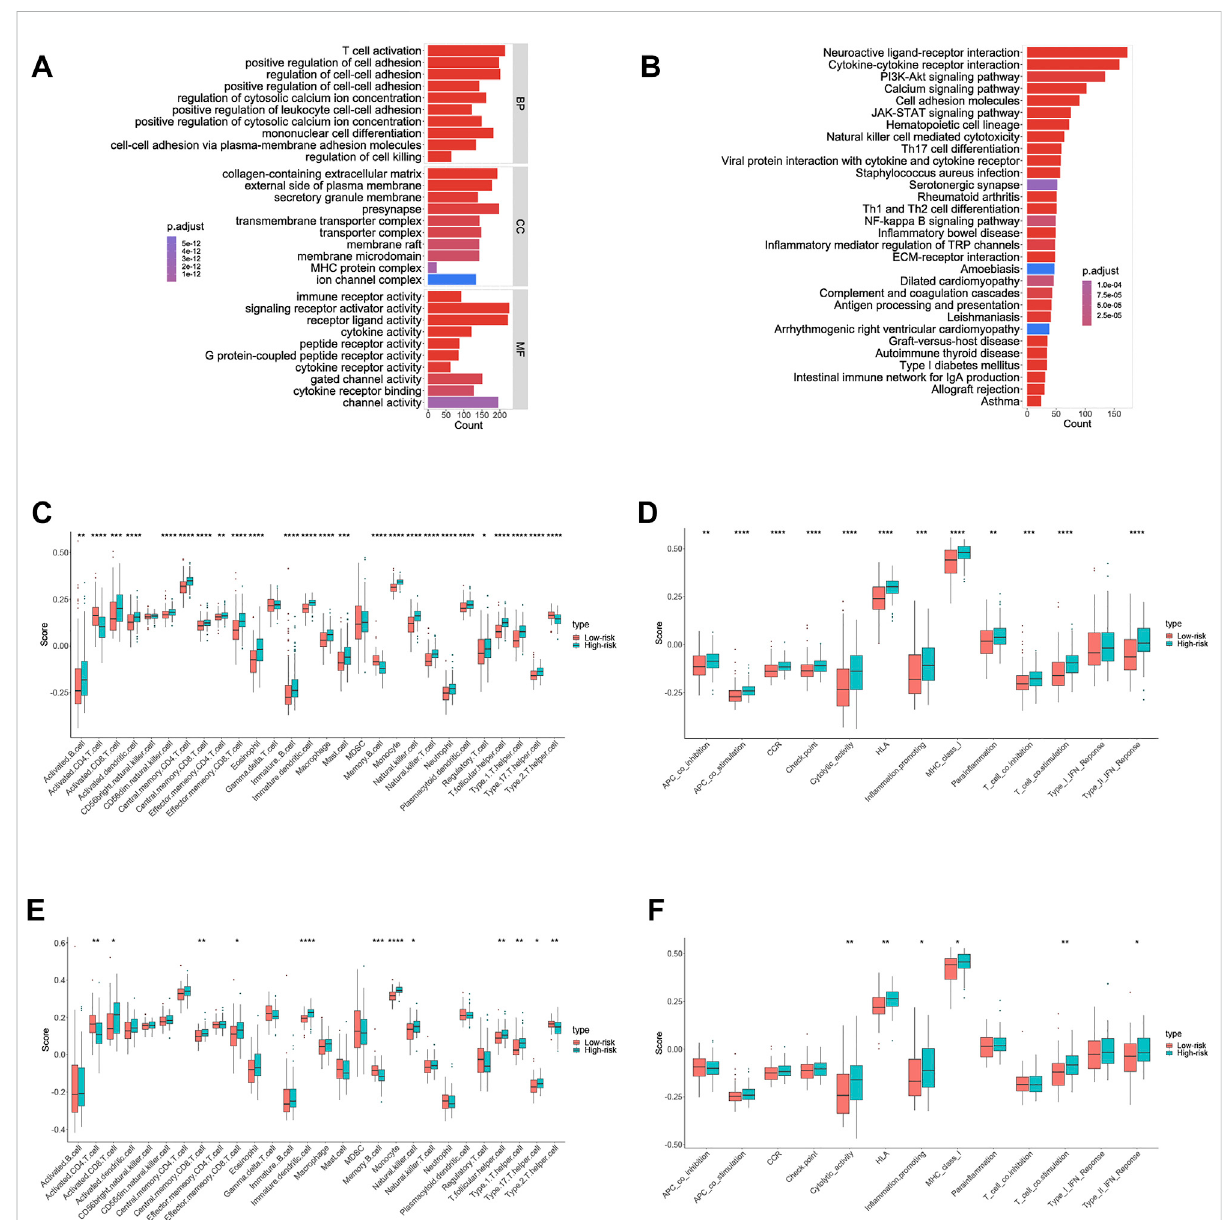
FIGURE 6 ResultsofGOandKEGGanalysesandcomparisonofthessGSEAscoresbetweenthehigh-andlow-riskgroupinthetrainingcohort. (A) Results of GO enrichmentin thetraining cohort. (B) Results ofthe KEGGpathway in thetraining cohort. (C) Scores of16 immunecells in thetraining cohort. (D) Scores of 13 immune-related functions in the training cohort. (E) Scores of 16 immune cells in the validation cohort. (F) Scores of 13 immune- related functions in the validation